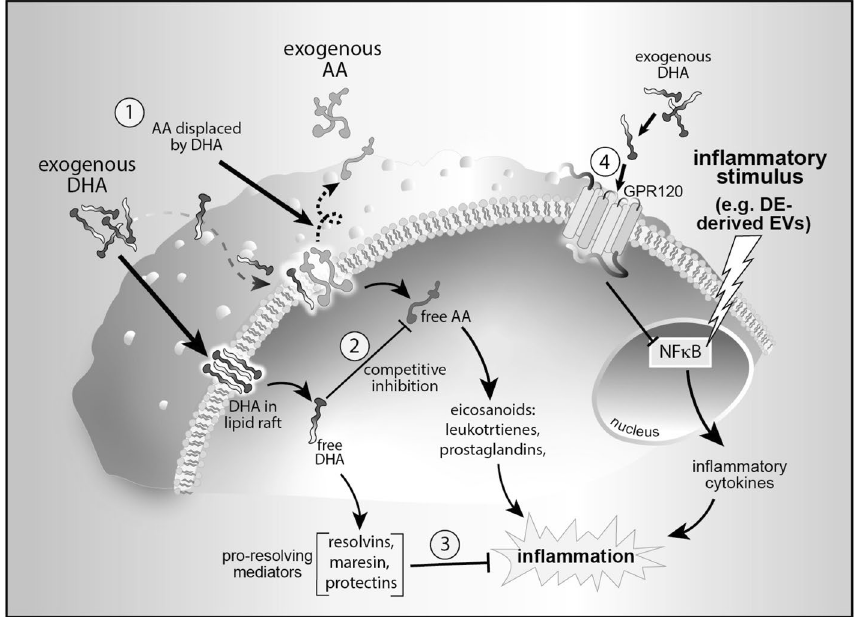
Figure 9. Schematic overview. Mechanism of n-3 PUFA-modulated suppression of EV-induced inflammation. Exogenous DHA competes with the more proinflammatory n-6 PUFA arachidonic acid (AA) for incorporation into cell membranes ( 1 ). Inside the cell, free DHA inhibits enzymatic conversion of AA to eicosanoids by direct competition ( 2 ). Specialized pro-resolving mediators are synthesized from free cytoplasmic DHA ( 3 ). Binding